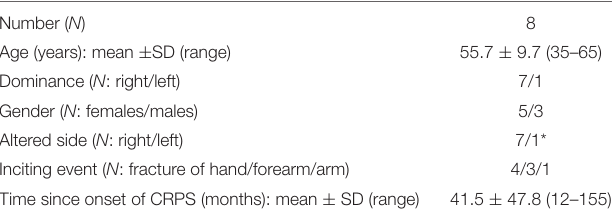
TABLE 1 | General characteristics of